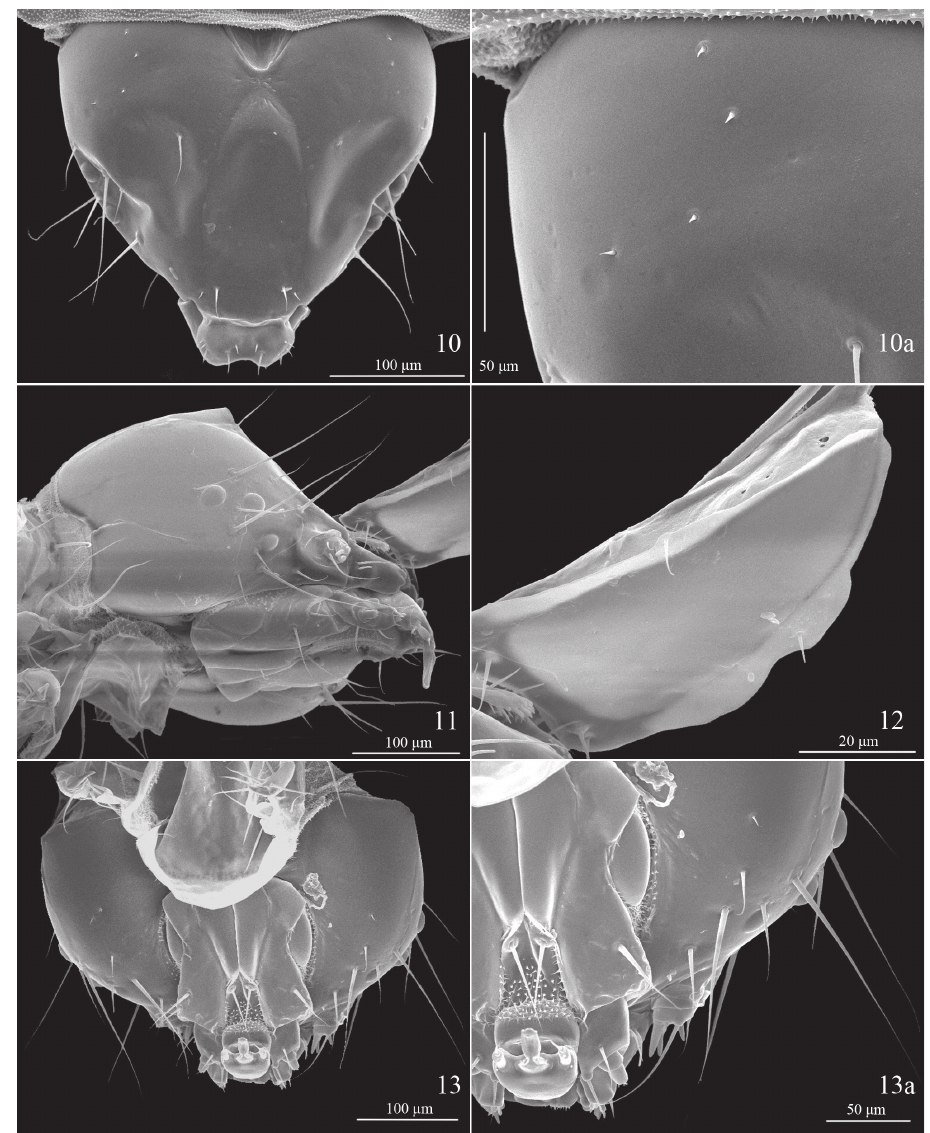
Figures 10−13. Last instar larva head chaetotaxy of Telamoptilia grewiae sp. n. 10 Dorsal view 10a close- up of MD setae 11 Ventral-lateral view, scanned from last instar larval skin 12 Frons, frontal-lateral view, same individual as 11 , 13 Dorsal view 13a close-up of SO and G